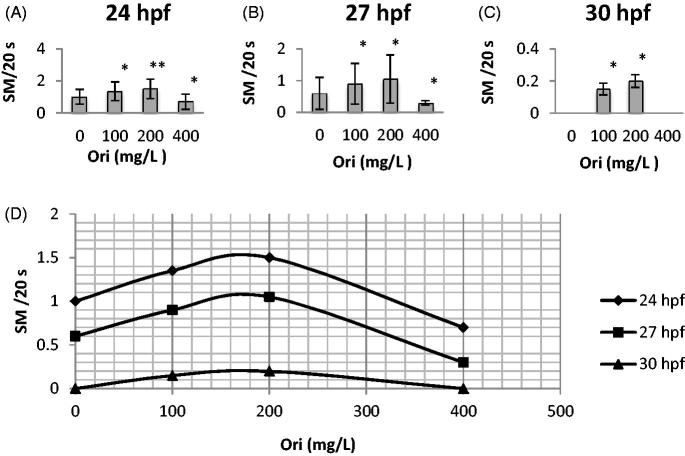
Effects of oridonin on spontaneous movements for zebrafish embryos. Note: Asterisks indicate statistically significant differences between different concentration of oridonin groups and the control (without oridonin) group (*p < 0.05; **p < 0.01). Each error bar represents the standard deviations of at least three experiments. A: 24 hpf; B: 27 hpf; C: 30 hpf. SM: Spontaneous Movements; Ori: Oridonin.